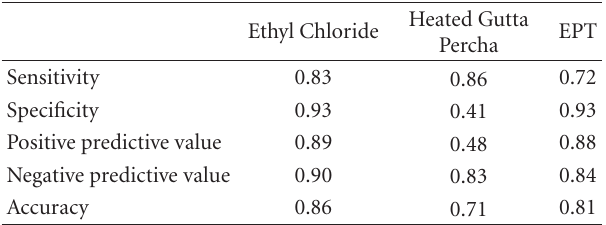
Table 1: Pulp test results from the Petersson et al. [105] study. The disease prevalence in this study was 39%. Note: the heat test with gutta percha recorded a higher number of false positives compared to ethyl chloride and